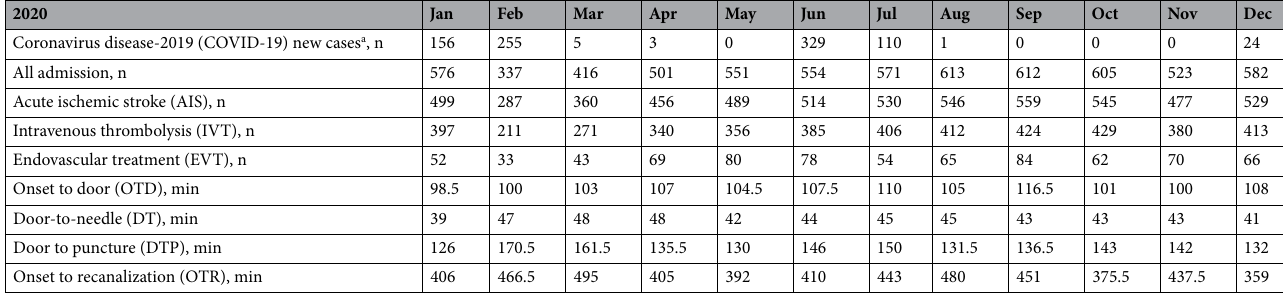
Table 3. Quality measures of the acute care provided for ischemic stroke in 2020. a Data was obtained from Beijing Municipal Health